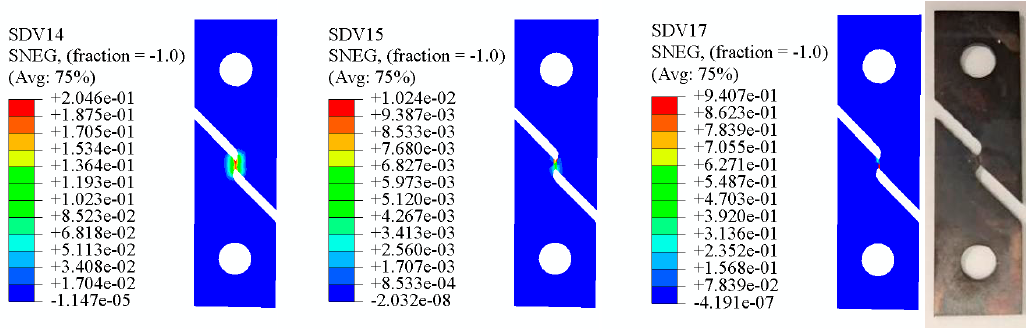
Figure 12. Equivalent plastic strain, VVF, shear damage at the beginning of microcrack in 0 ◦ specimen, and the result diagram of the specimen.